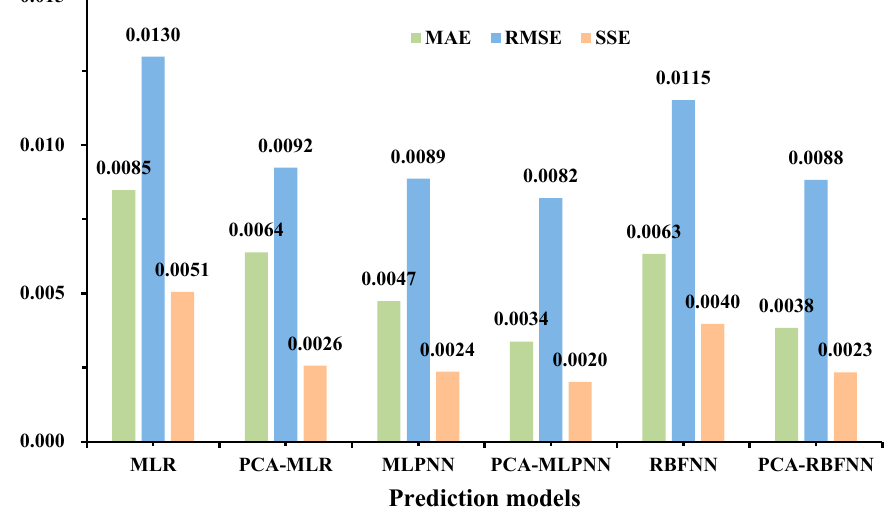
Figure 7. Comparison of model evaluation metrics.